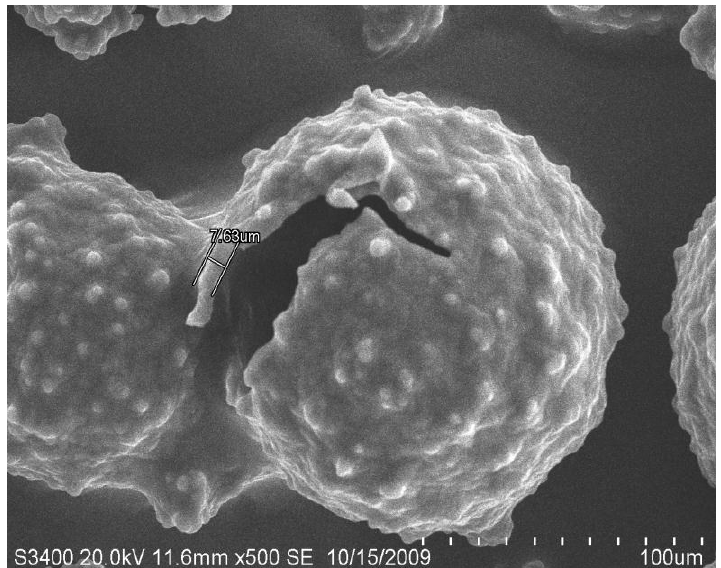
Figure 4. SEM image showing the MPCM shell